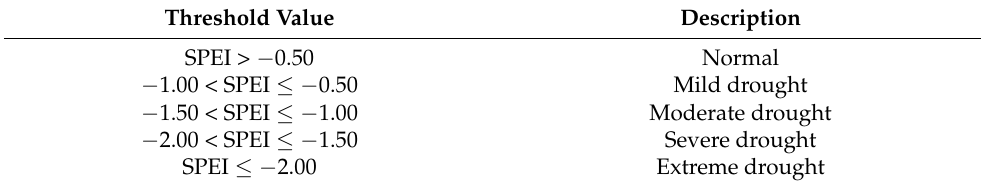
Table 1. Threshold values of the SPEI index